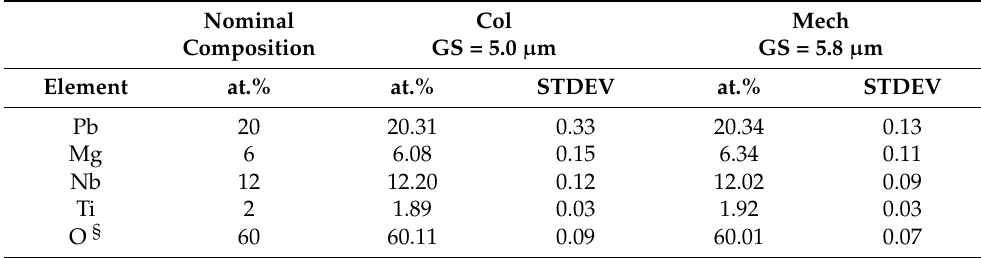
Figure 5. Microstructures of Col ( a – d ) and Mech ( e – h ) PMN-10PT samples from combined SEM ( a , b , e ) and TEM ( c , d , f – h ) techniques. Circles in ( a ) point out the triple-junction points (TJP), magnified in ( b – d ), where secondary phases of Mg- and Pb-silicates crystallized. Arrows in ( e ) point out the MgO grains at the grain boundaries and trapped MgO inclusions in the matrix grains. Panel ( f ) shows clear TJPs of the Mech sample. Panels ( g , h ) are TEM images of MgO inclusions. Table 1. Chemical composition and the standard deviation (STDEV) of the Col and the Mech ceramics, determined by